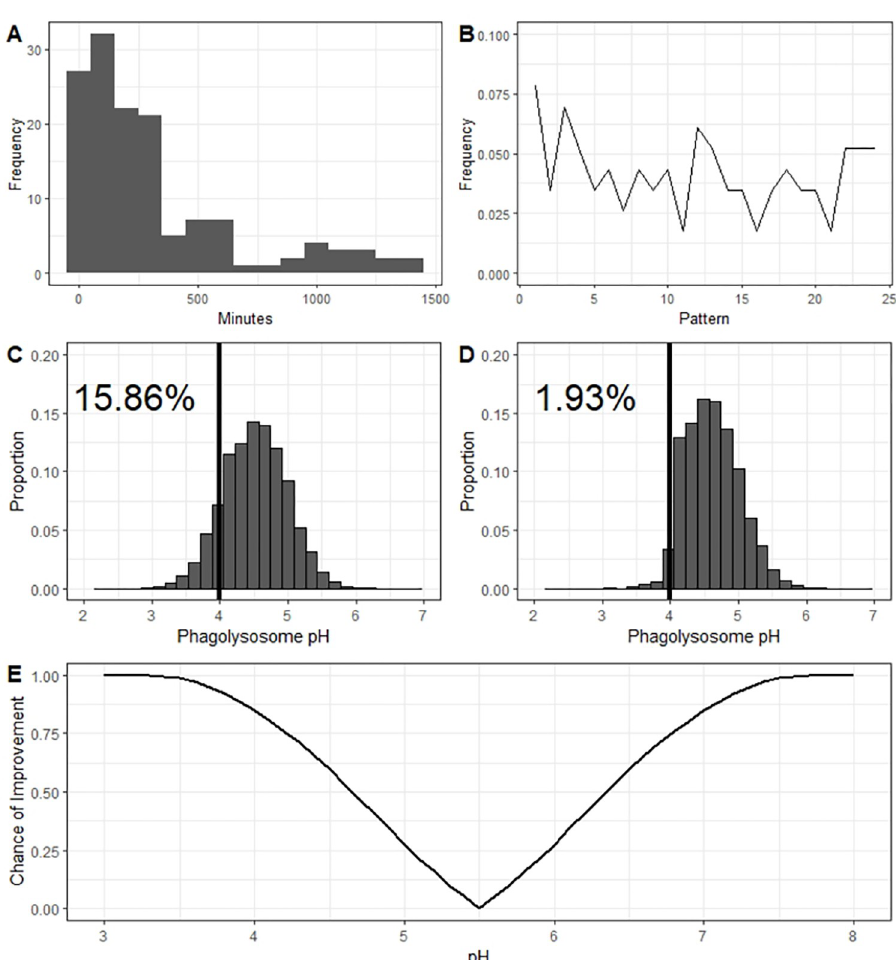
Fig 3. Dynamics of Dragotcytosis. A. Distribution of the times at which C . neoformans yeasts initiated host cell exit strategies. Both Vomocytosis and Dragotcytosis events are represented here. Bin widths are set to 100 and the data depicted spans 139 samples from 12 independent experiments. B. Ordinal pattern analysis for the intervals between events. Intervals were gathered and analyzed within experiments and total proportions of individual ordinal patterns summed between experiments. C. Hypothetical phagolysosomal pH distributions if C . neoformans particles were to undergo no Dragotcytosis events. D. Modelled phagolysosomal pH distributions if C . neoformans particles were to undergo one Dragotcytosis event if their resident phagolysosomal pH is < 4. Even a single round of low pH triggered Dragotcytosis drastically shifts the distribution to the right resulting in a greater proportion of C . neoformans hospitable phagolysosomes. Labelled percent values reflect the proportion of hypothetical phagolysosomes inhibitory to C . neoformans (pH < 4, black vertical line) in each scenario. E. Hypothetical chance of an ingested C . neoformans to find a more hospitable phagolysosome in the context of pH assuming equal likelihood of migrating to an M0, M1, or M2